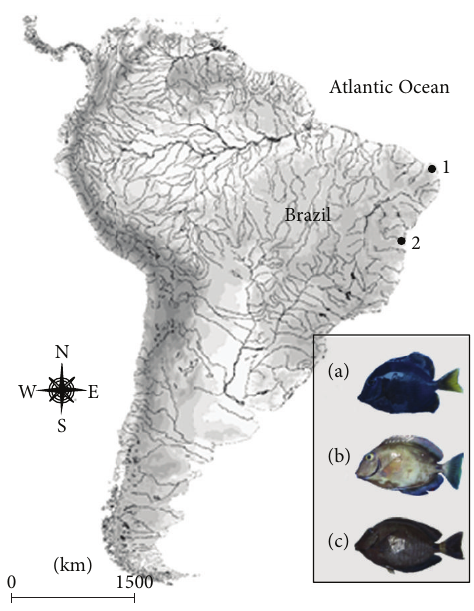
Figure 1: Map of South America showing the collections sites of Acanthurus coeruleus (a), A. bahianus (b), and A. chirurgus (c) in the states of Rio Grande do Norte (1) and Bahia (2), northeastern